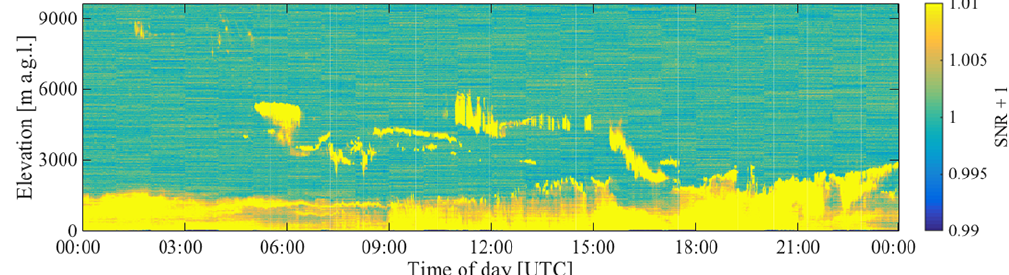
Figure 8. Corrected SNR from a Halo Doppler lidar operating at Hyytiälä on 21 May 2014.